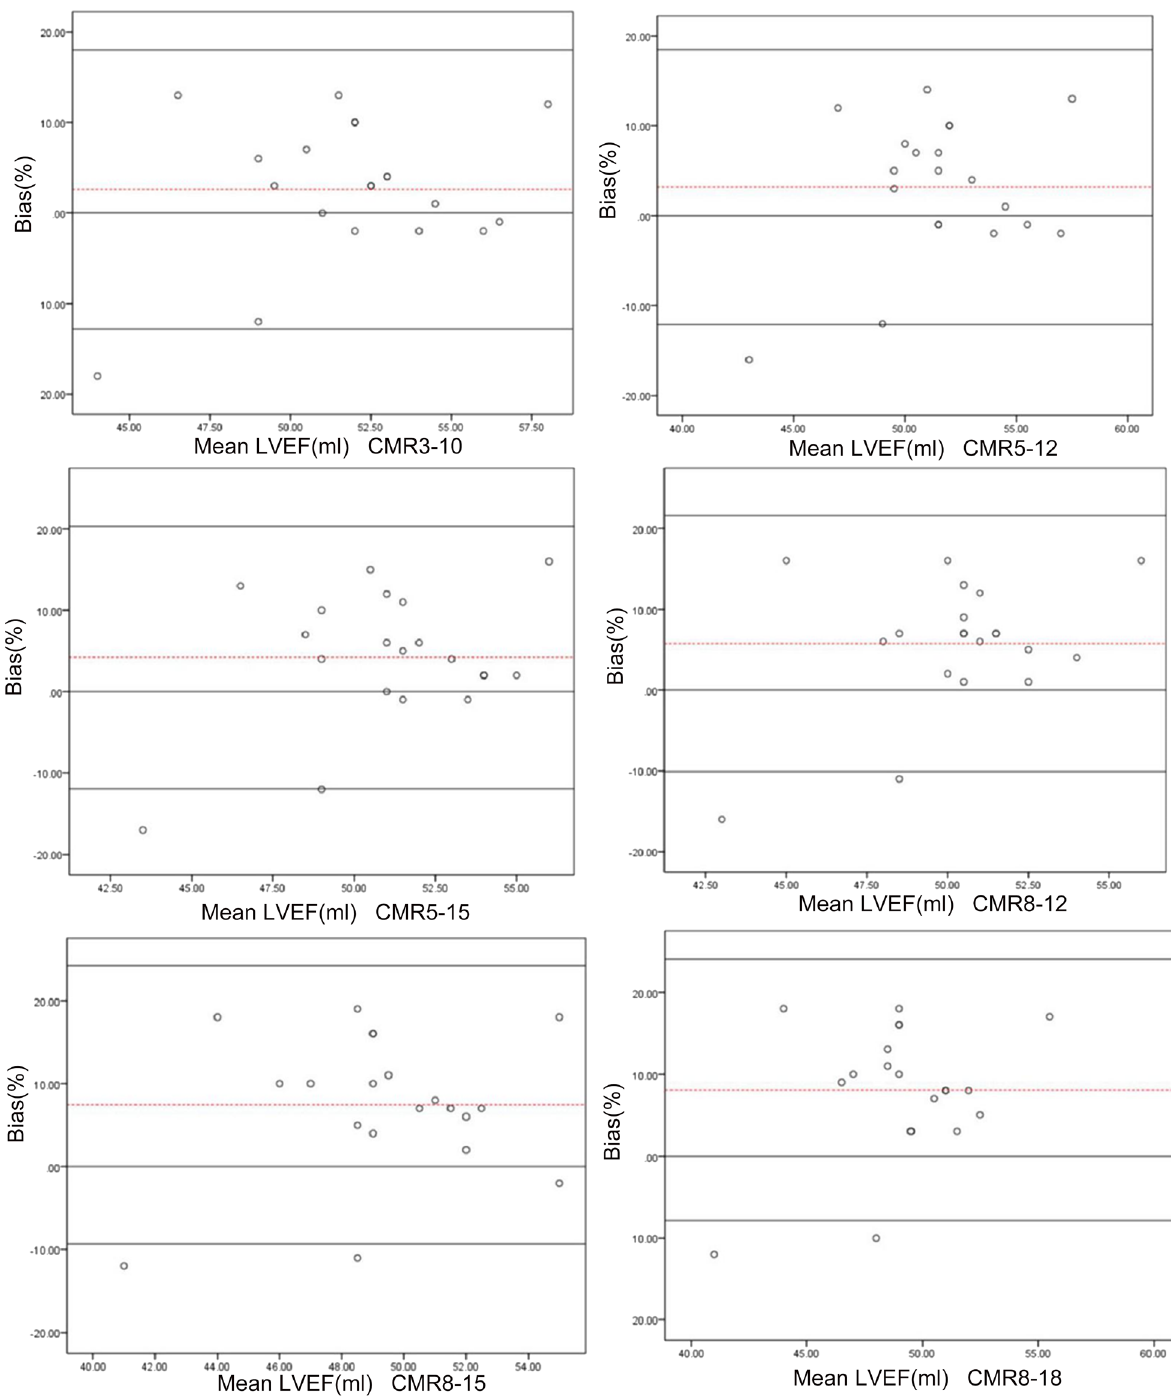
Fig. 4 Bland ‒ Altman test for consistency of the left ventricular ejection fraction measured by SPECT with different reconstruction parameters and by cardiovascular magnetic resonance (CMR) in the normal group. The dashed line represents the mean of the difference (Xd). The three solid lines are the upper limit of agreement (LOA) of the difference (Xd 1.96SD), zero, and the lower LOA of the difference (Xd 1.96SD) from top to bottom, + − respectively. Xd mean of the difference, SD standard deviation of the